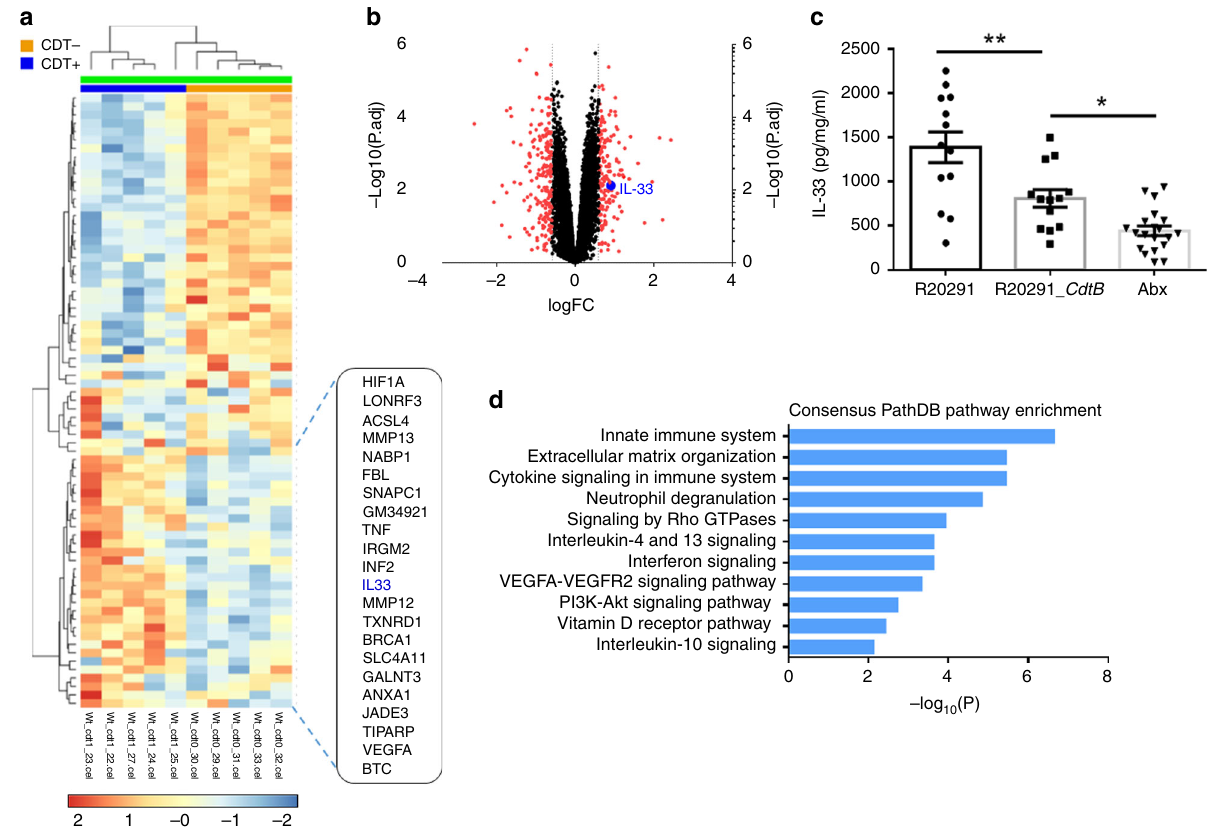
Fig. 1 IL-33 is upregulated by host in response to C. dif fi cile infection. Mice were infected with R20291 (CDT + ) or attenuated R20291_ cdtb (CDT-) and whole-cecal tissue transcriptomic analyses was performed on day 3 post infection. a Heatmap of genes upregulated (red) or downregulated (blue) in response to CDT toxin. b Volcano plot highlighting IL-33 (blue) among genes altered (>0.5 logFC = red). c ELISA of IL-33 protein within the cecal tissue (day 3) of R20291 infected, R20291_ cdtb infected, or uninfected antibiotic-treated (ABX) mice. d Enriched pathways of the top upregulated transcripts (log FC > 0.5; p < 0.05) listed by signi fi cance ( − log10(p)) and created using the ConsensusPathDP database. ( a , b , n = 5 biologically independent animals). c Comparison made by ANOVA ( n = 13, 13, 20 combined from two independent experiments). Individual n numbers in each panel are shown in same order as their corresponding groups from left to right, and this arrangement is applied to other relevant fi gures in the text. Statistical signi fi cance is demarked as * P < 0.05, ** P < 0.01, and *** P < 0.001, throughout the text. Error bar indicates